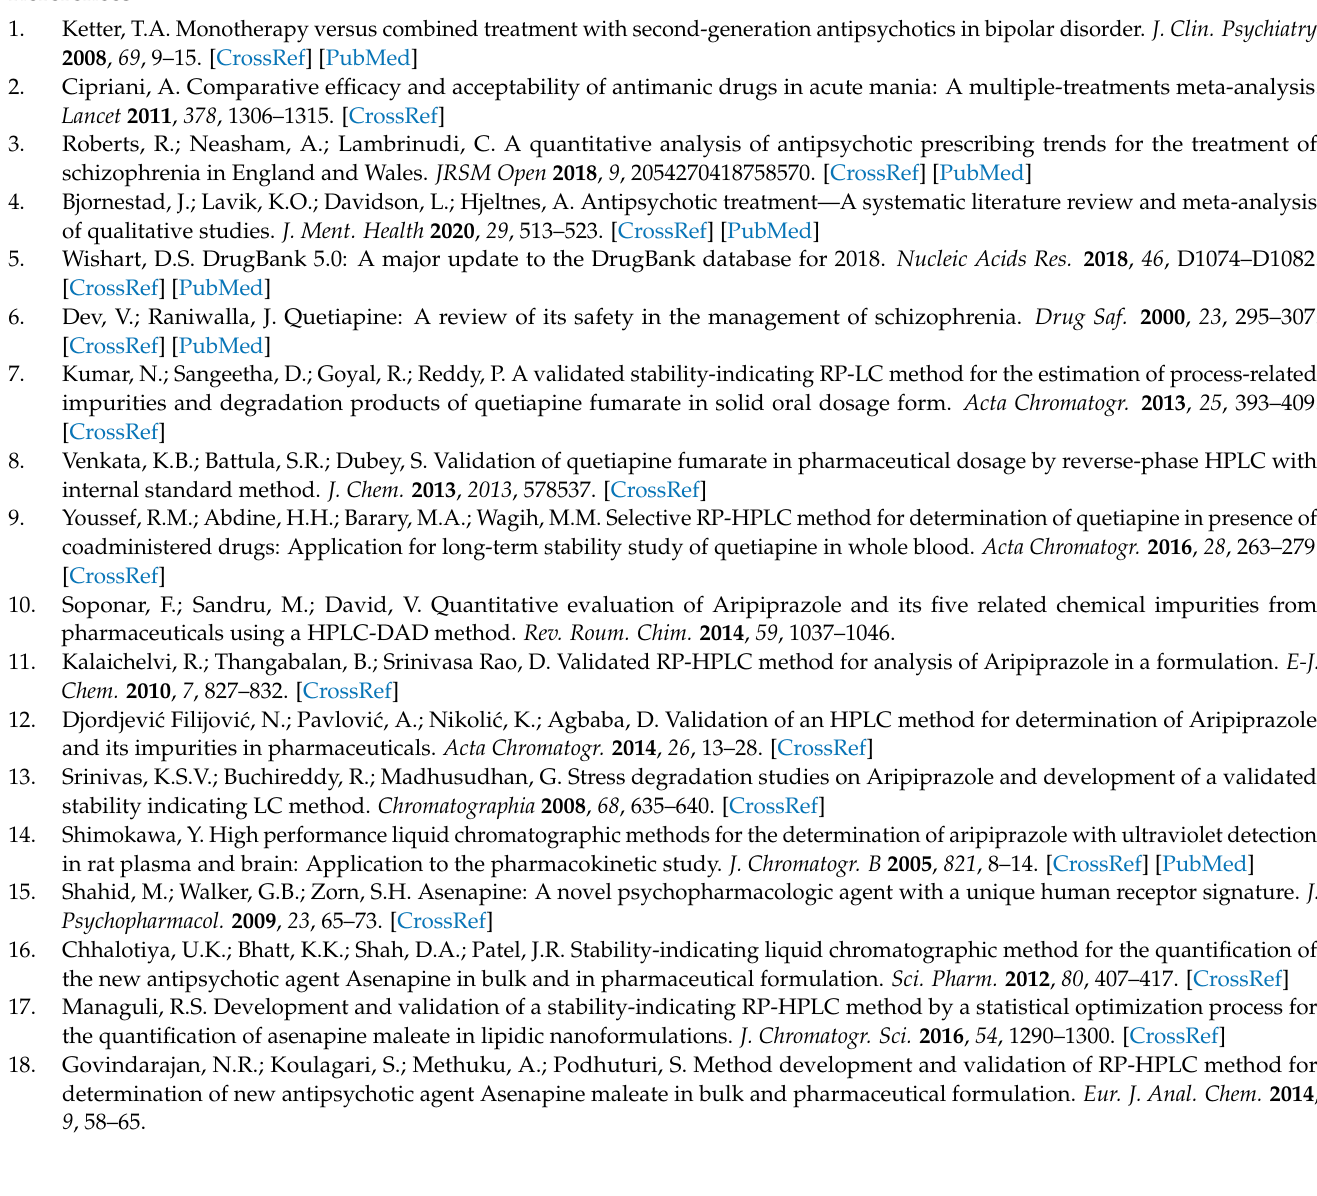
HPLC methods; Table S5: A comparison of figures of merit between proposed green HPLC and the previously reported HPLC methods for the single determination of the selected